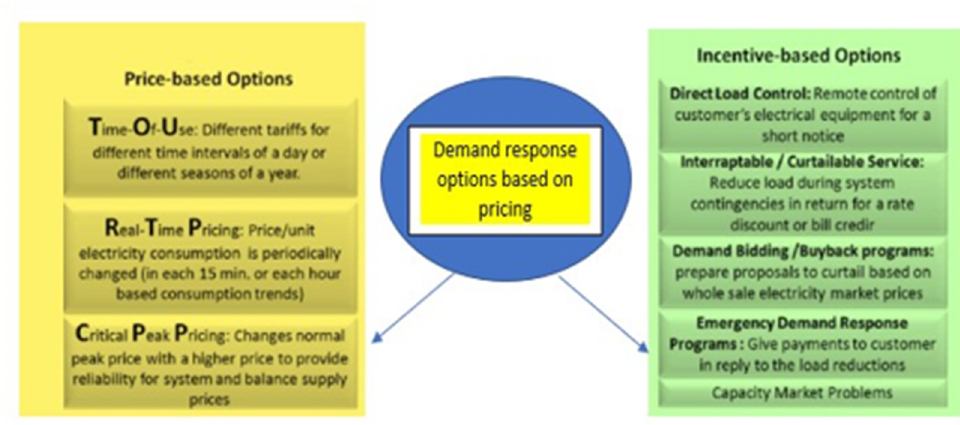
Figure 6. Electricity industry tariff options.